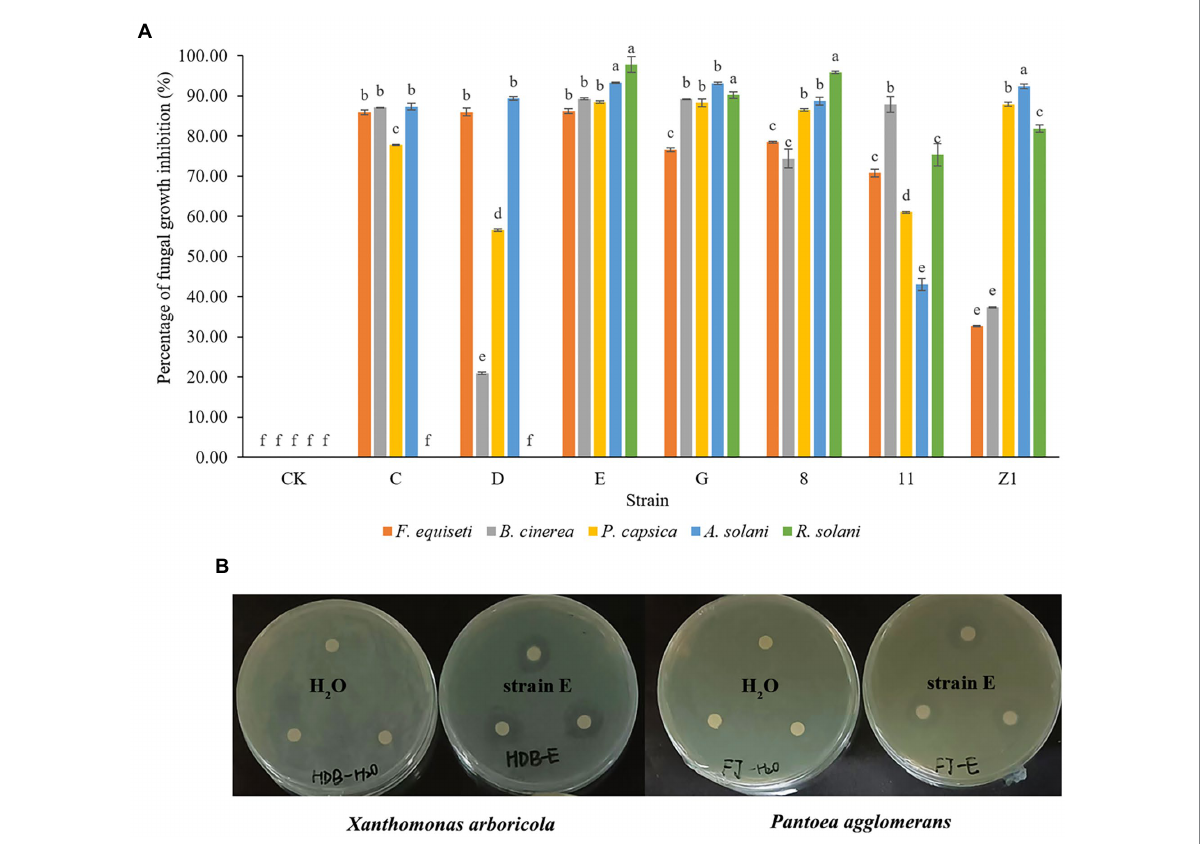
FIGURE 3 Antagonistic activities of isolated bacterial strains against economically important fungal and bacterial pathogens. (A) Antagonistic activity of seven bacterial strains against five fungal pathogens using dual culture assay. Three replicates of each treatment were used. Fungal pathogens cultured on PDA plates was used as control. Bars labeled with different letters indicate significant difference ( p < 0.05) according to Duncan’s multiple range test. (B) Antagonistic activity of strain E against two bacterial pathogens using disc diffusion assay. Sterile water was used as a